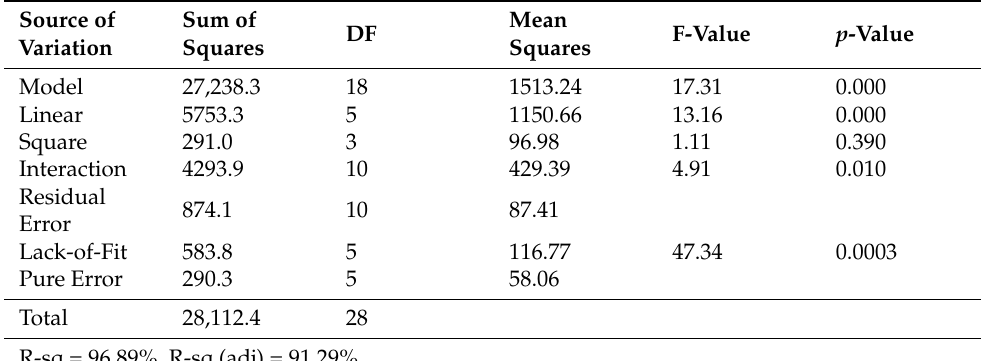
Table 9. The ANOVA results for bending strength response using the Design-Expert